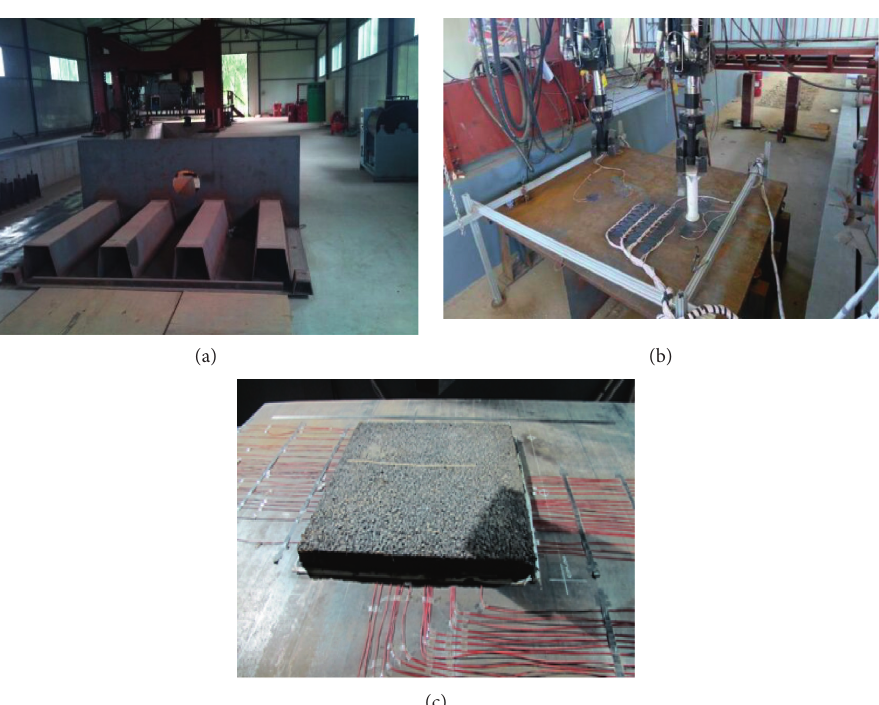
Figure 19: Processing and installation process of the full-scale structural test model with the SBDP synergistic effect. (a) The orthogonal anisotropic bridge-panel model. (b) The full-scale test model after completion. (c) The full-scale test model with the